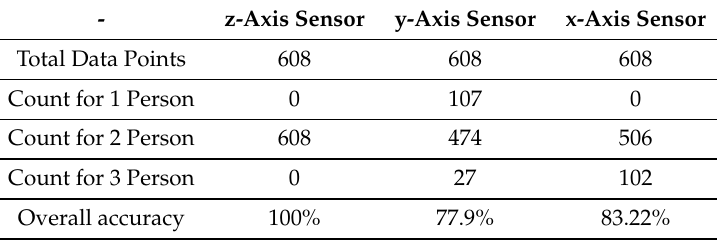
Table 6. Connected component: two people